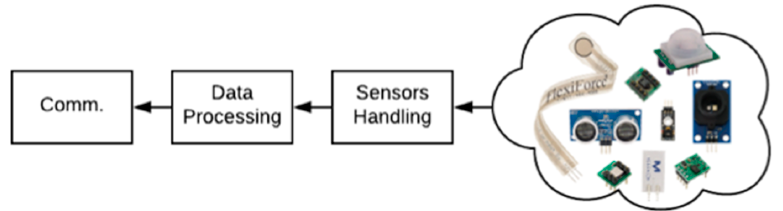
Figure 2. General block diagram of a physical system architecture.